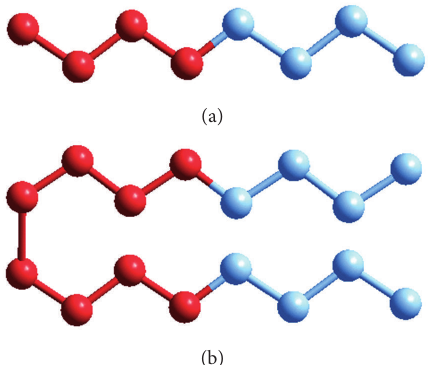
F1:Structureof(a)monomericand(b)dimericstudiedlattice surfactants. Red beads are heads and light blue beads are